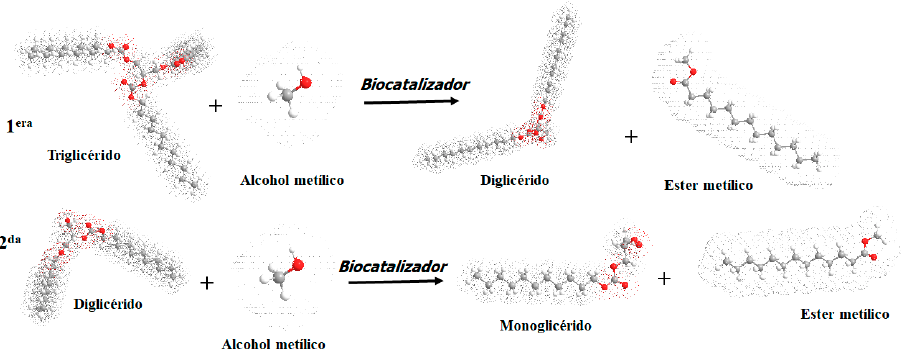
Figure 13. Transesterification reaction. First stage: conversion of triglycerides to diglycerides